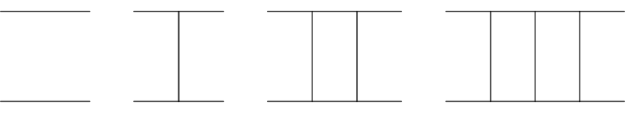
Figure 4 . The first four contributions to the ladder expansion of four-point function in the s -